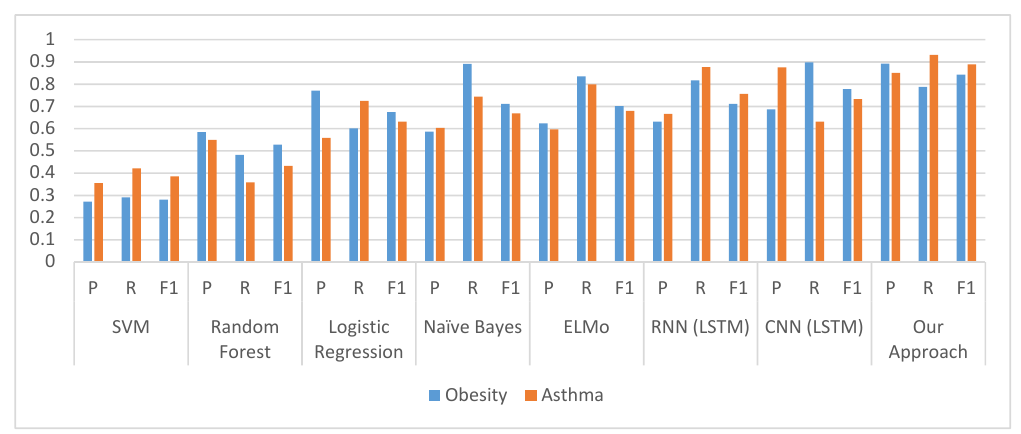
Figure 4. Performance statistics based on comparison between our approach and other approaches, using recall (R), precision (P), and F1 measures (F1) .